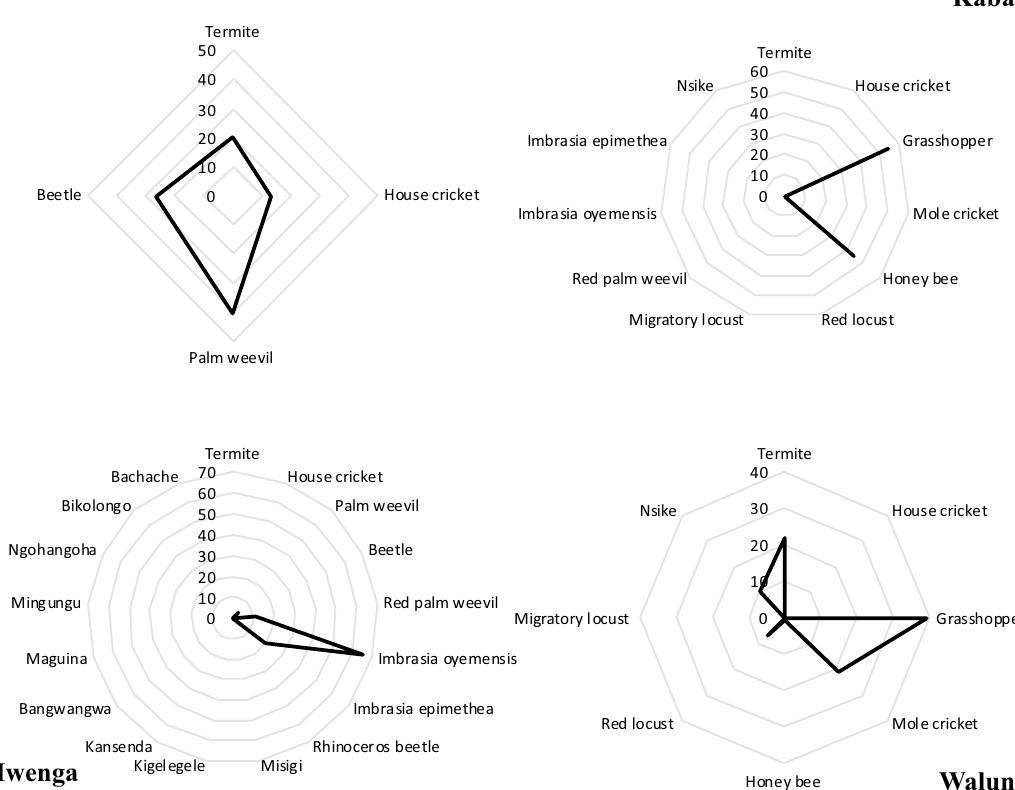
Figure 3. Most preferred edible insects in each Territory (n = 130). This is the number of times each edible insect is preferred. The preference is expressed in percentage. (Figures plotted using Microsoft Excel for Mac 16.56 and mixed using Microsoft PowerPoint for Mac 16.29.1 https:// www. micro soft. com).